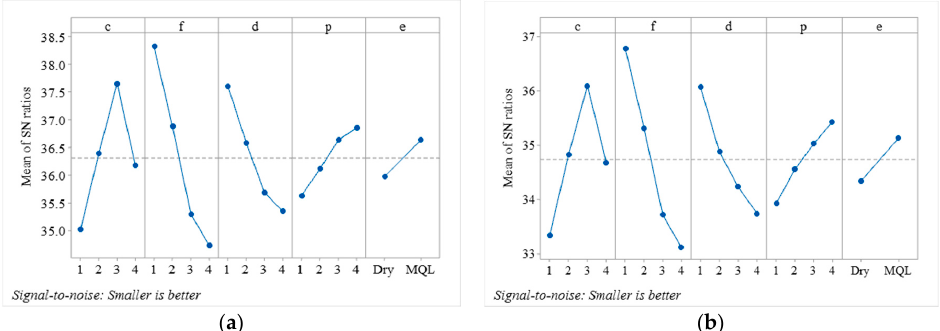
Figure 6. Main effect plot for means of Signal to noise ratio of shape deviations ( a ) circularity ( b ) cylindricity. ( b )